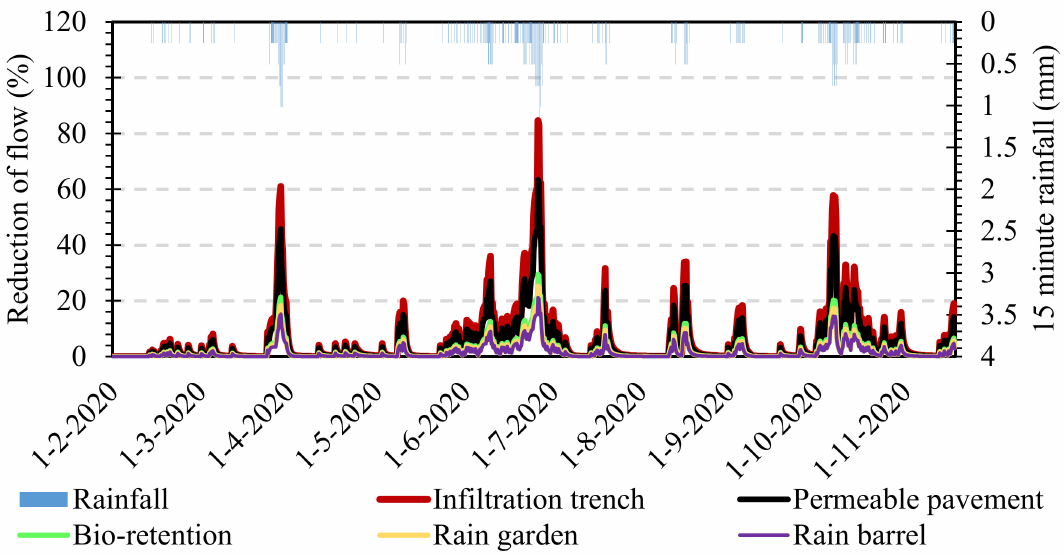
Figure 11. Reduction of flow (in %) for different LID types compared to the existing stormwater